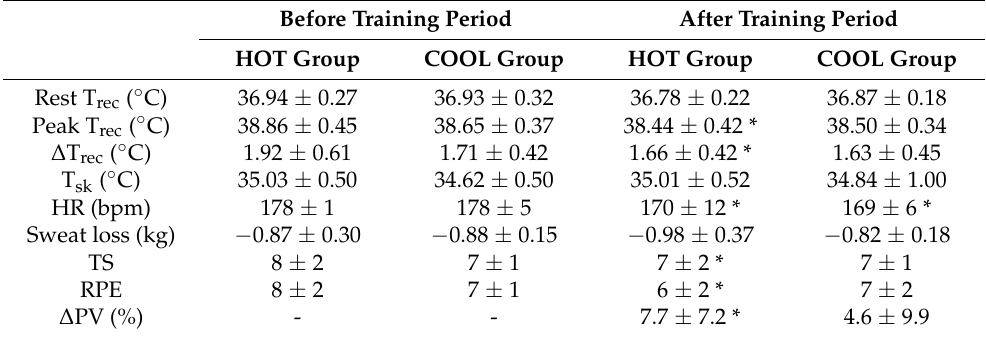
Table 2. Thermoregulatory and subjective variables during HST before and after the training period. Before Training